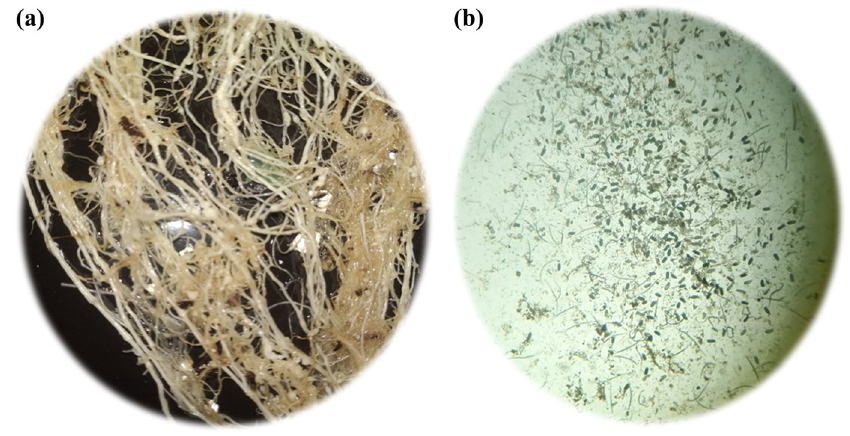
Figure 1: Infected tomato root plants with RKNs ( a ) maintained in the Kadoorie Agriculture Research Center ’ s glasshouse in Palestine Technical University – Kadoorie. Extracted viable juveniles and eggs ( b )